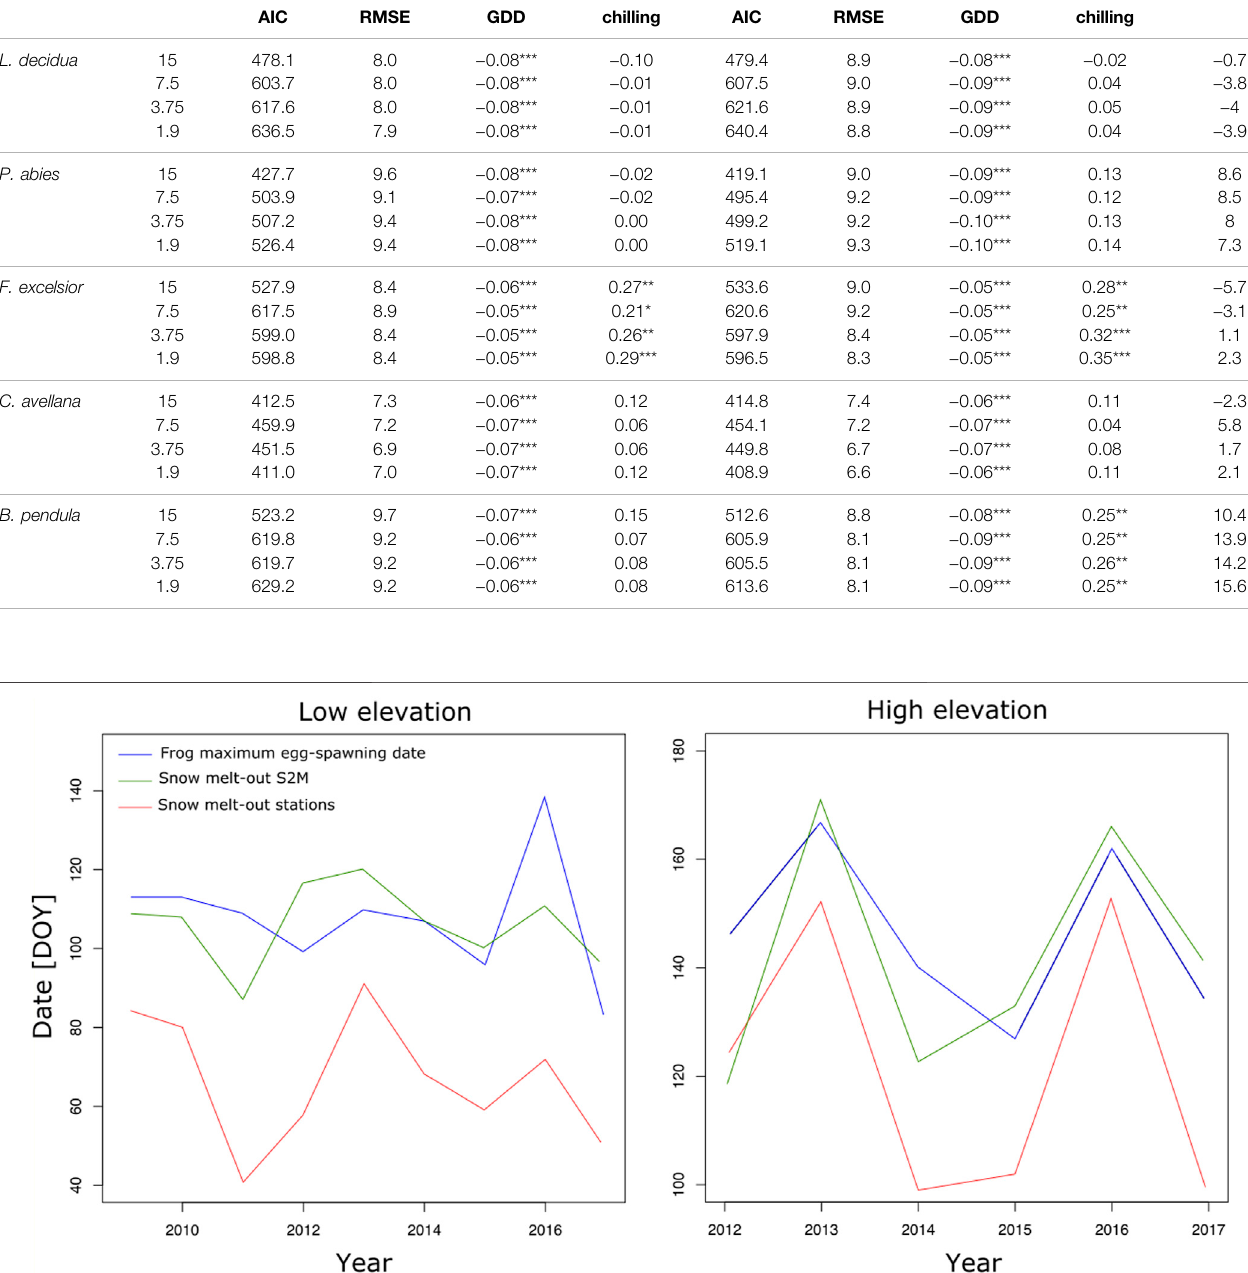
Frontiers in Earth Science |